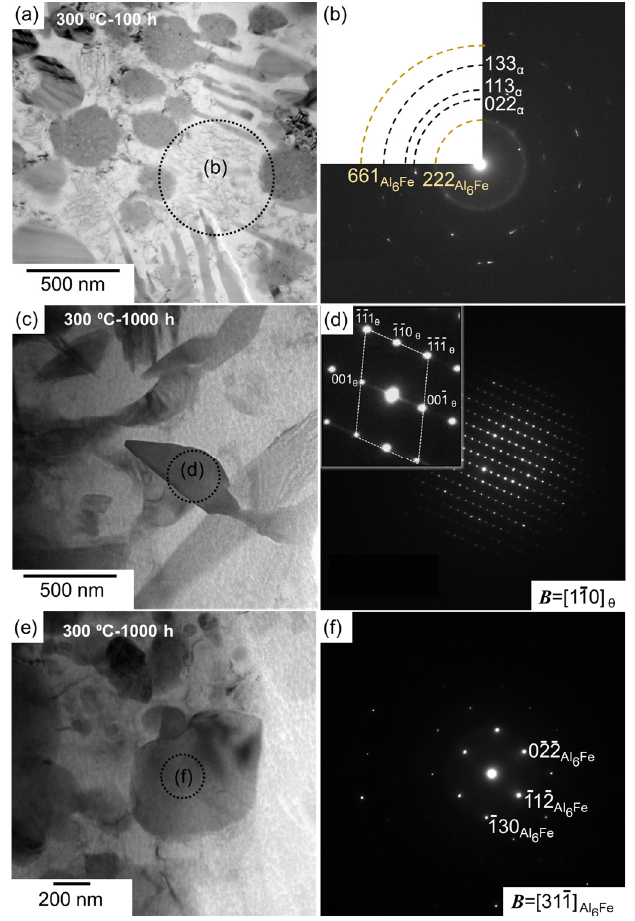
Figure 5. ( a , c , e ) Bright-field TEM images and ( b , d , f ) the corresponding SAED patterns of ( a , b ) pristine and ( c – f ) thermally exposed L-PBF-built samples (300 °C/1000 h).